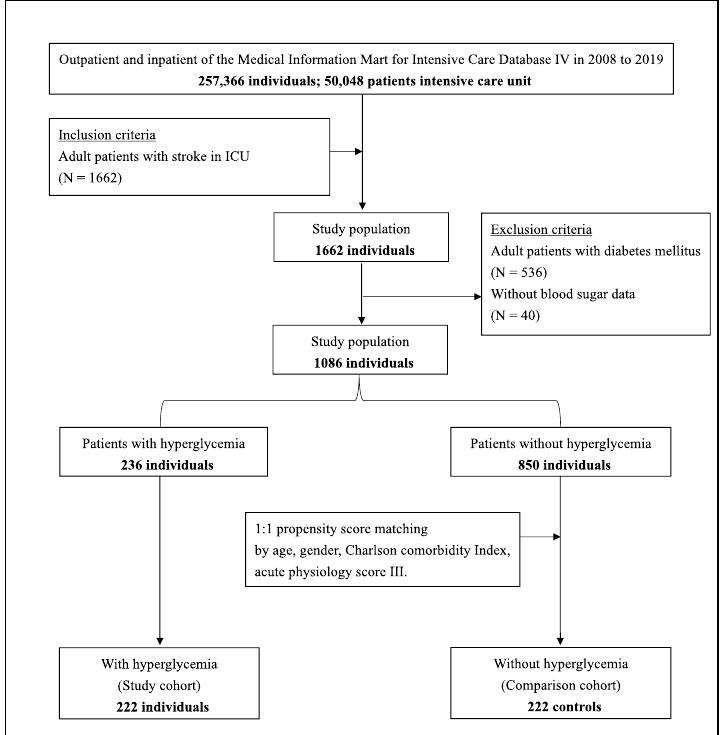
Figure 1. Flow diagram of data extraction from the Medical Information Mart for Intensive Care-IV database and further grouping layout.